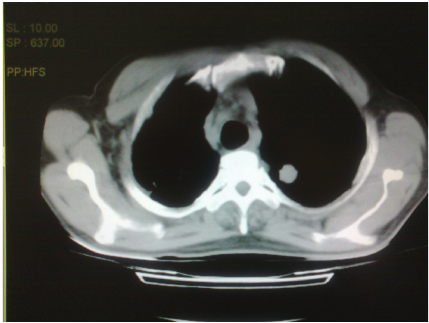
Figure 1: Nodular lesion located at the apex of the left lung.